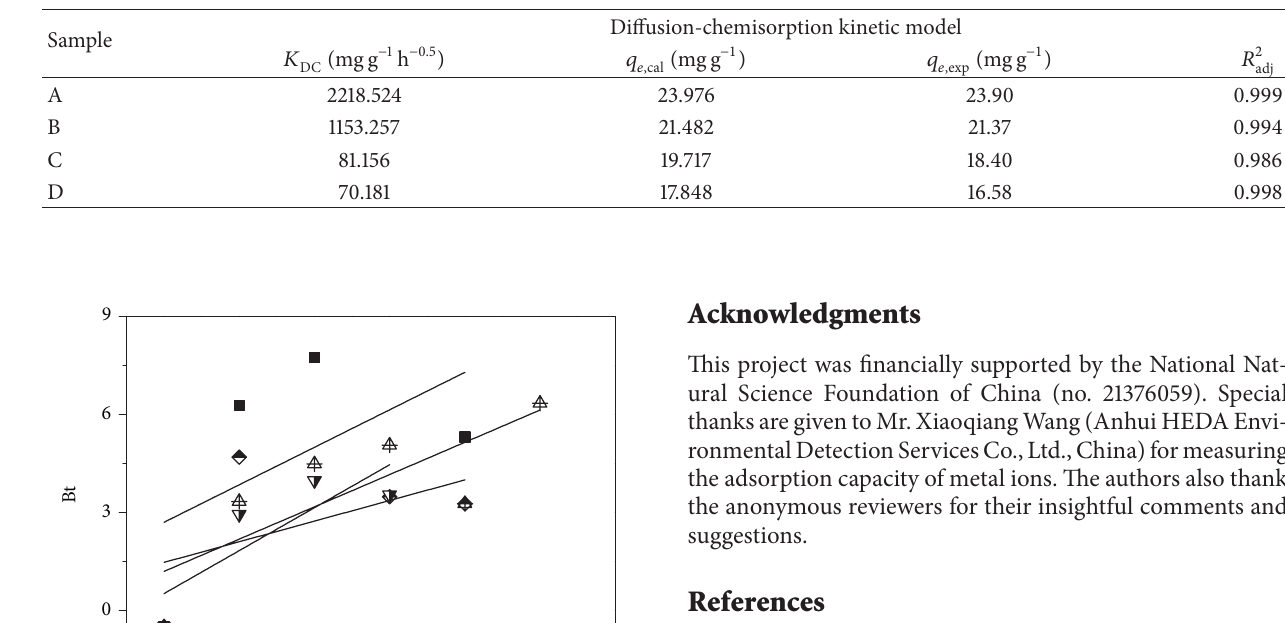
Table 2: Diffusion-chemisorption kinetic parameters for strontium removal.